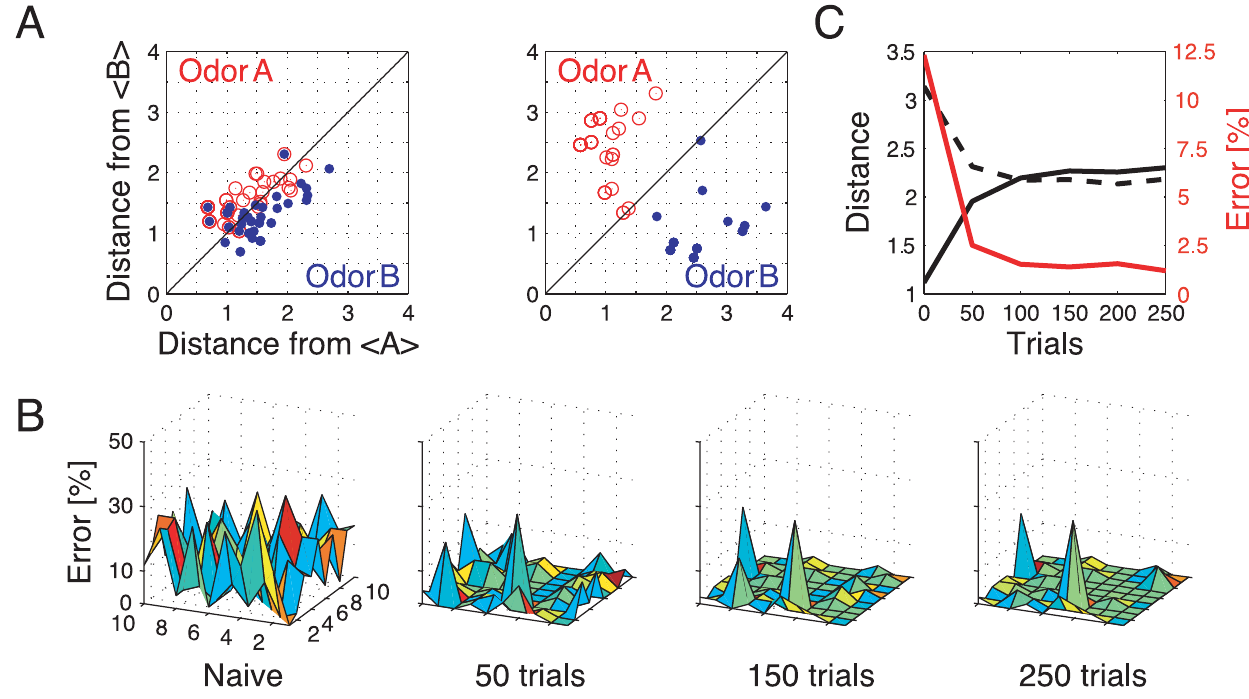
Figure 7. Discrimination of similar odors in 19-dimensional KC space. (A) Clustering of responses to two similar odors A and B ( P S =0.02) for a naive system (left panel) and after STDP-based synaptic tuning (right panel). Representations for 1-s odor trials of each odor (dots) in KC space were compared by computing the Euclidean distance from the average response to odor A (vertical axis), and the average response to odor B (horizontal axis). Diagonal line delineates classification. For this odor pair, classification was perfect after learning. (B) Wrongly classified trials (error) between pairwise comparisons of 10 similar odors at different stages of learning. (C) The substantial average drop in classification error rate across all odor pairs in (B) (red, right axis) can be ascribed to a matching increase of the distance between average odor responses (‘‘cloud centers’’ in KC space; black, left axis) and a decrease in ‘‘cloud size’’ (twice the average distance of single responses to one odor from their respective ‘‘center’’; dashed black line, left